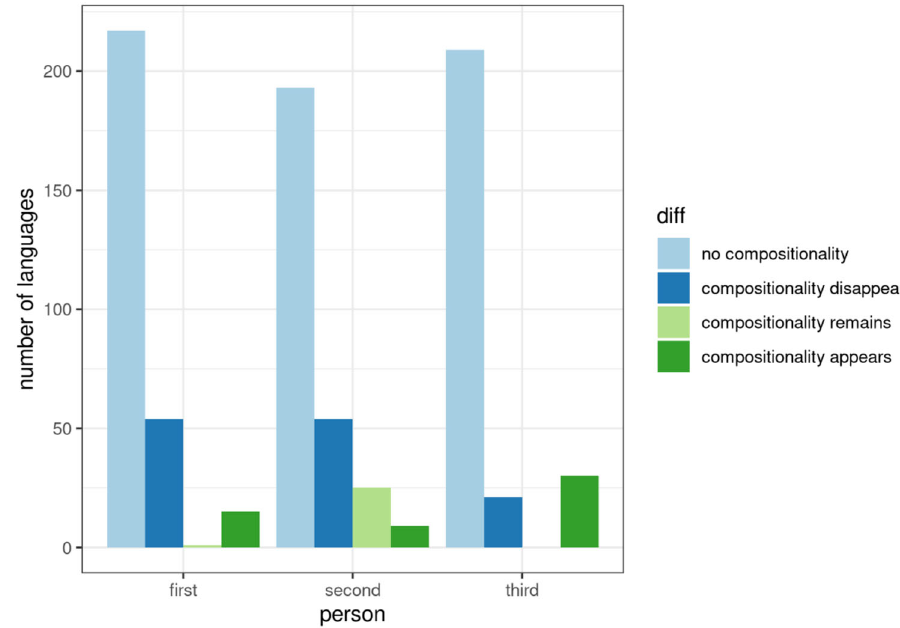
Fig. 4 Number of languages that increased/decreased number of compositional persons.